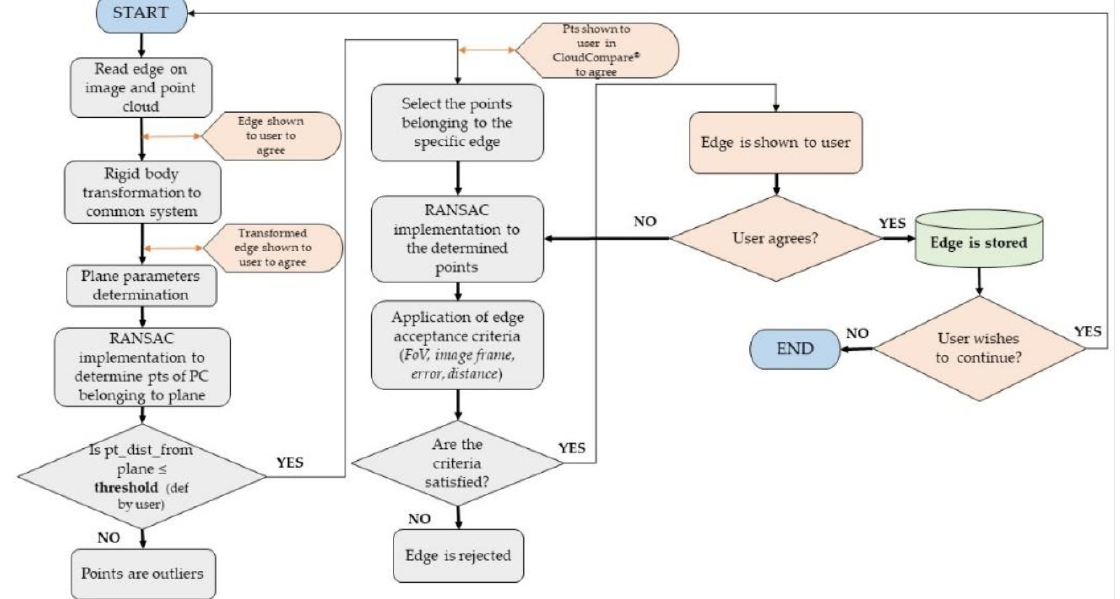
Figure 2. The flowchart of the developed algorithm.